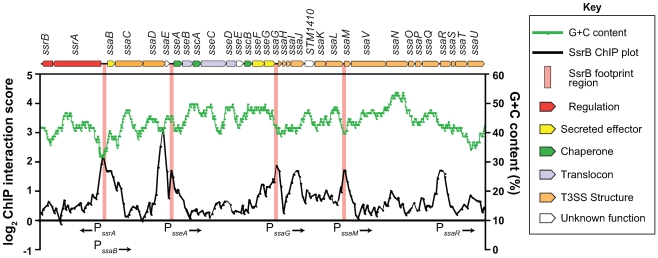
The SsrB binding profile at the SPI-2 locus.Plotted are the SsrB ChIP interaction scores (black trace) for all probes within the SPI-2 locus. ChIP-on-chip experiments were performed with S. Typhimurium grown in SPI-2 inducing (LPM) and non-inducing (LB) conditions. ChIP score was calculated as LB (control/experimental)/LPM(control/experimental) where LB scores were used to normalize the data. Regions of SPI-2 footprinted by SsrB are highlighted with vertical pink bars. G+C content across the region is plotted as a green trace. Genes in the SPI-2 genomic island (top) are plotted to scale and are coloured according to function (see key).